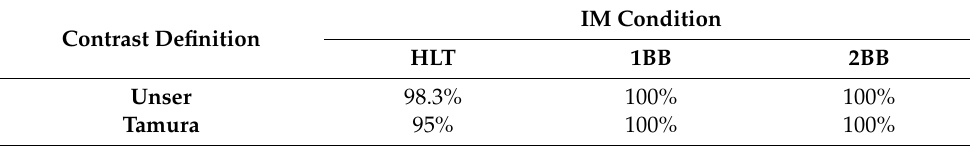
Table 3. Effectiveness results for identifying and classifying BRBs, utilizing contrast as a detection